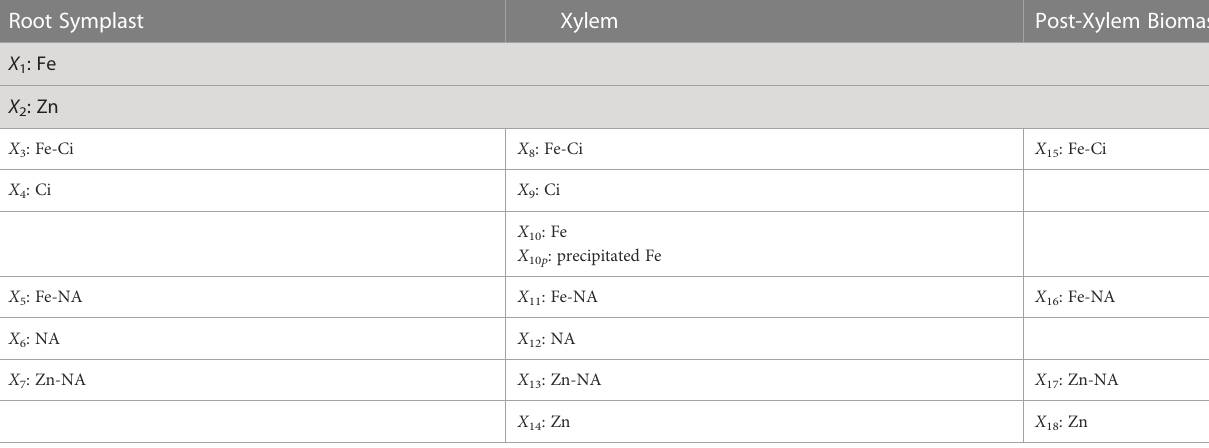
TABLE 1 Dependent variables in the model depicted in Figure 1 . Root